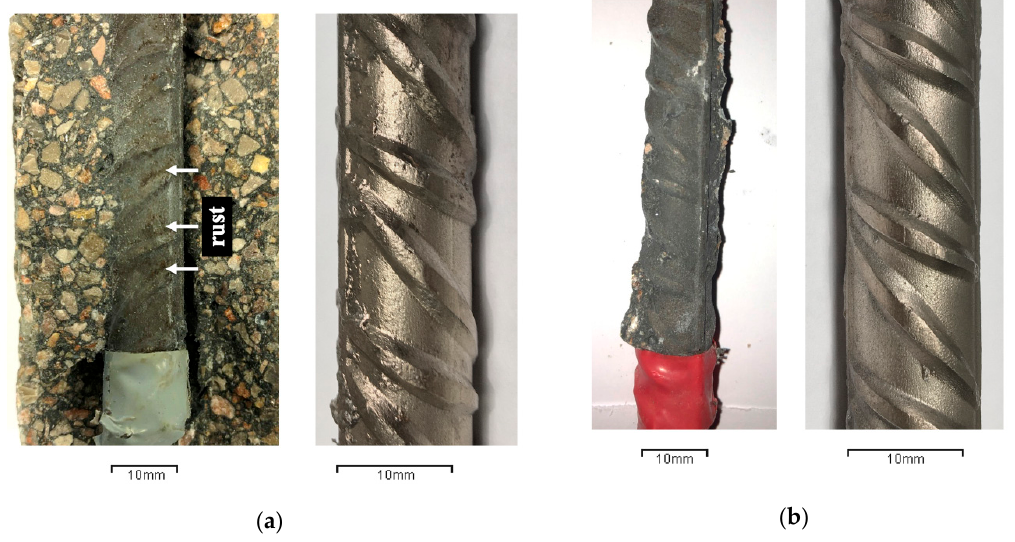
Figure 14. ( a ) Rebar in CFA-0L concrete; ( b ) rebar in CFA-20L concrete.